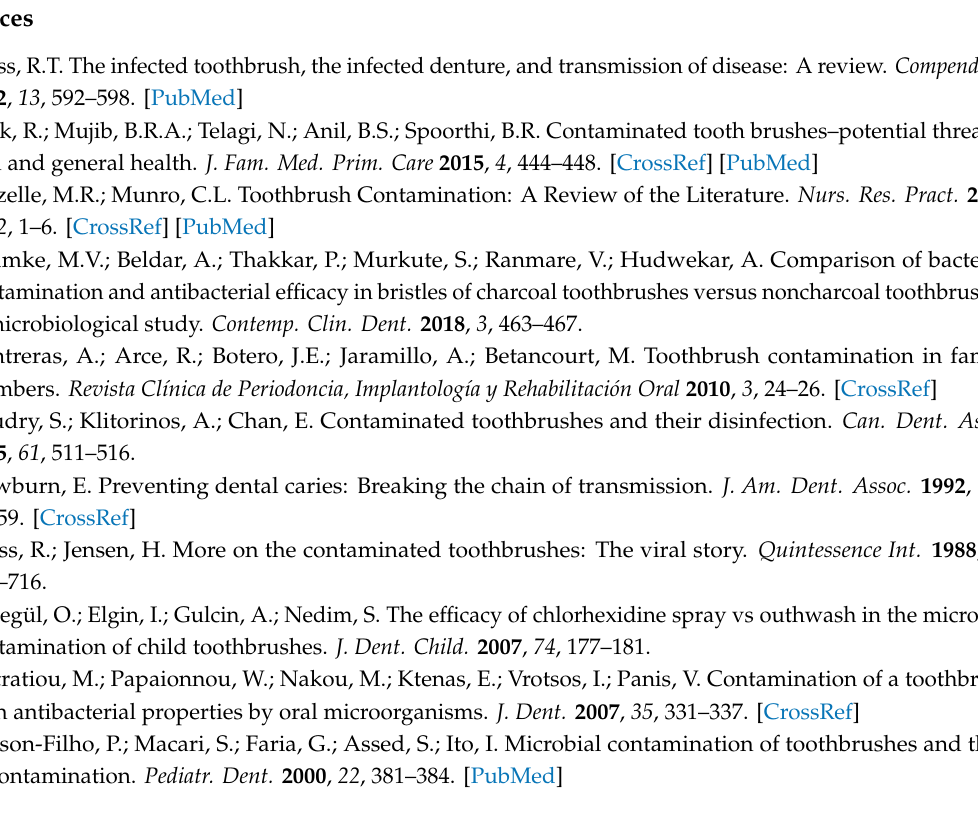
Table S1: Detailed summary of taxa (phylum, class, order, family, and genus) found on